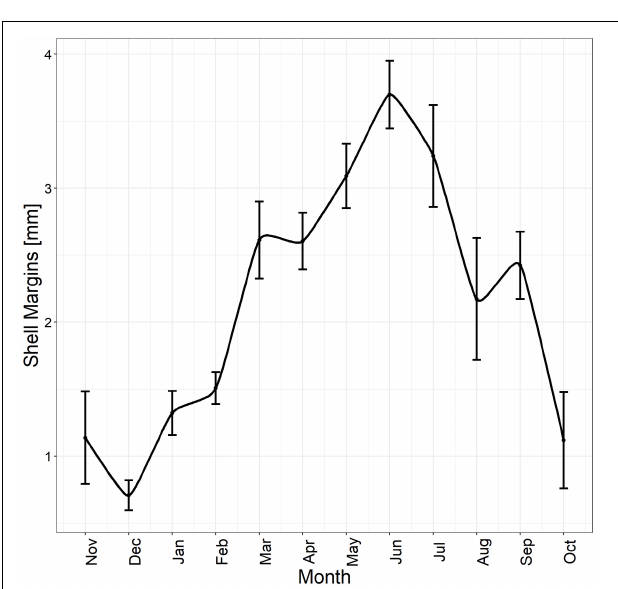
FIGURE 4 | Edge analysis. Different mean shell margin extents across months and associated SE (black bars) of 353 specimens analyzed throughout the year, highlighting the maximum margin extent occurring during the summer